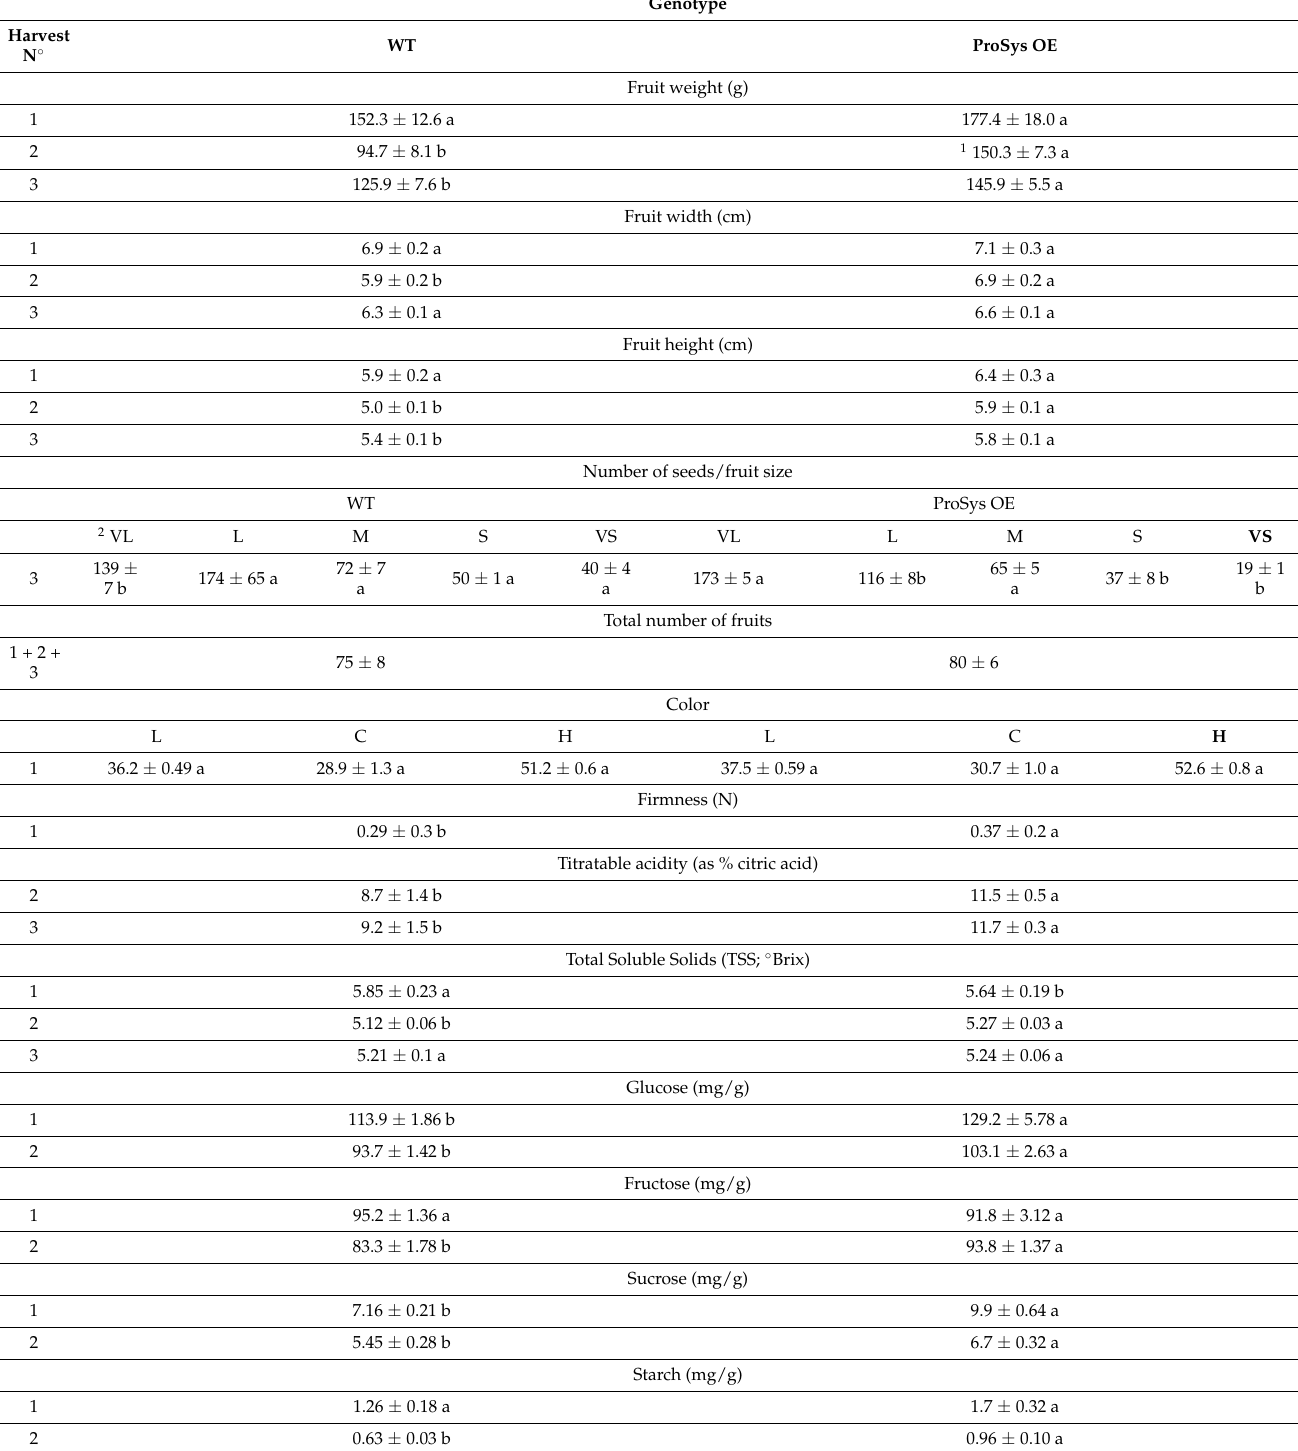
Table 3. Physicochemical properties and reproductive traits of fruits harvested from wild-type (WT) and prosystemin over- expressing (ProSys-OE) plants. Fruits were obtained from WT untransformed tomato plants and from plants overexpressing the ProSys precursor protein of the systemin peptide hormone. Fruits from three different seasonal harvests and having different sizes were